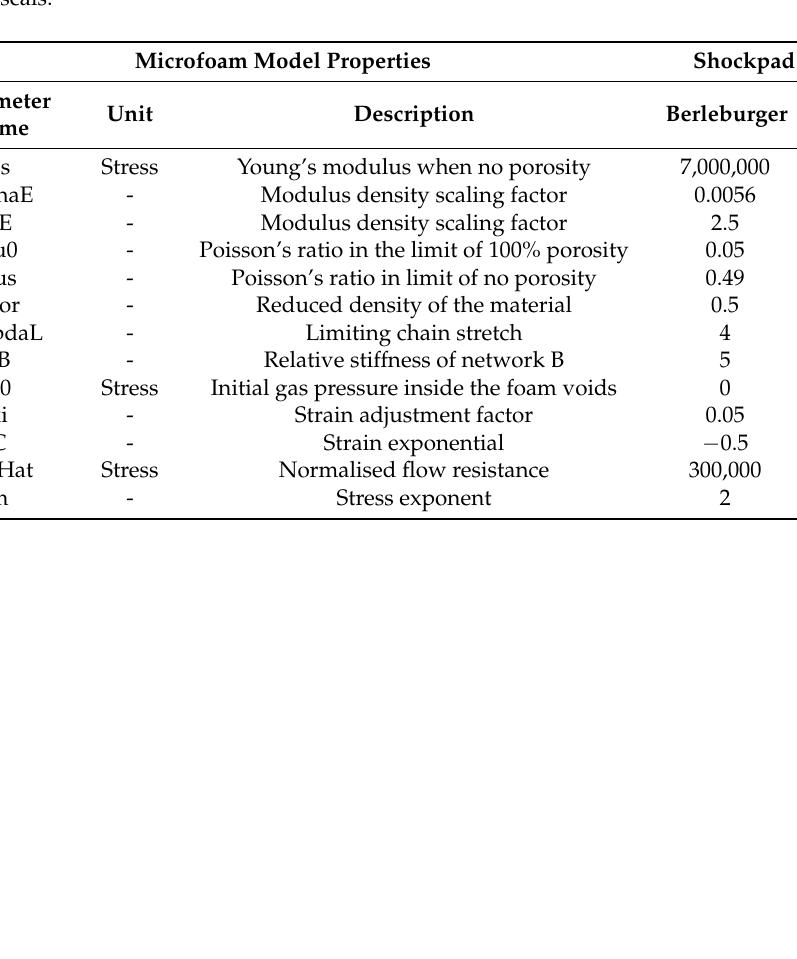
Table 2. Optimised microfoam model coefficients for the two shockpad models. Stress outputted in